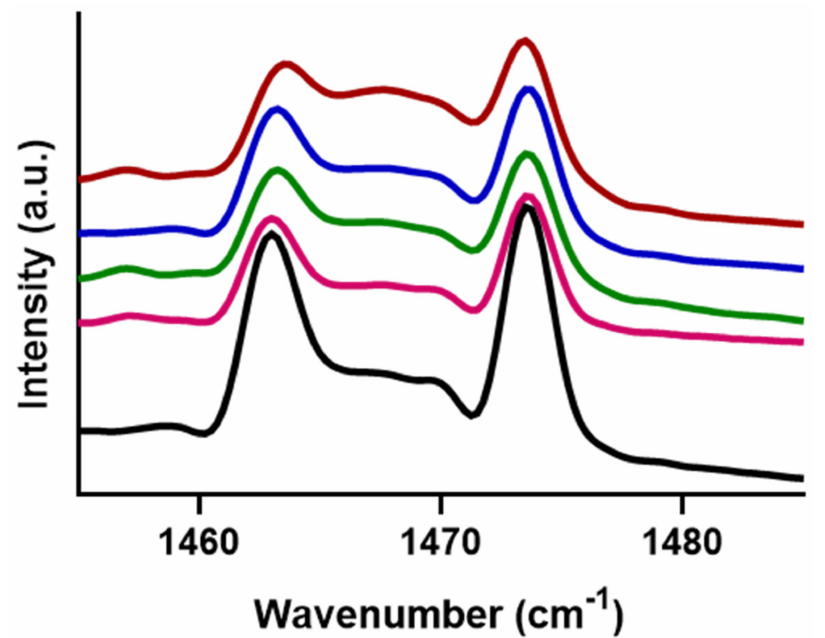
Figure 5. δ CH 2 for models containing FFA C16 content at 1.8 (black), 20 (magenta), 30 (green), 40 (blue), and 50 (red) percent of the total FFA content at 10 ◦ C. Regardless of FFA C16 content, the splitting distance between the orthorhombic peaks does not change; however, the intensity of the central hexagonal peak at 1468 cm − 1 increases with increasing C16